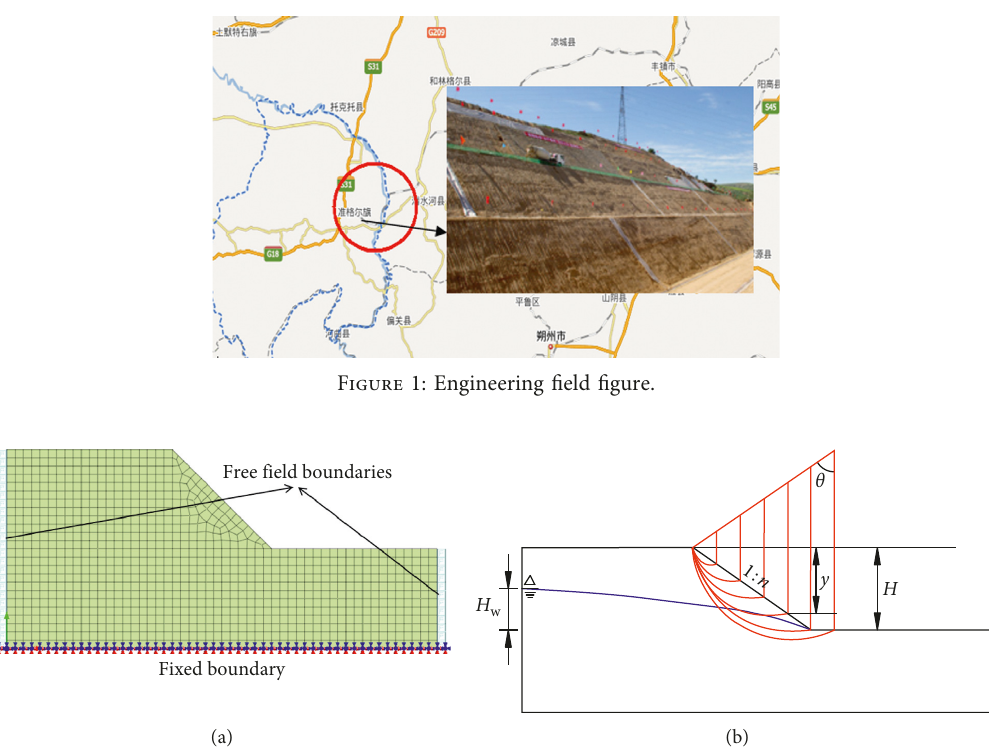
Figure 2: Analysis model of the slope (reproduced from the study of Huang et al. [20], under the Creative Commons Attribution License/ public domain).